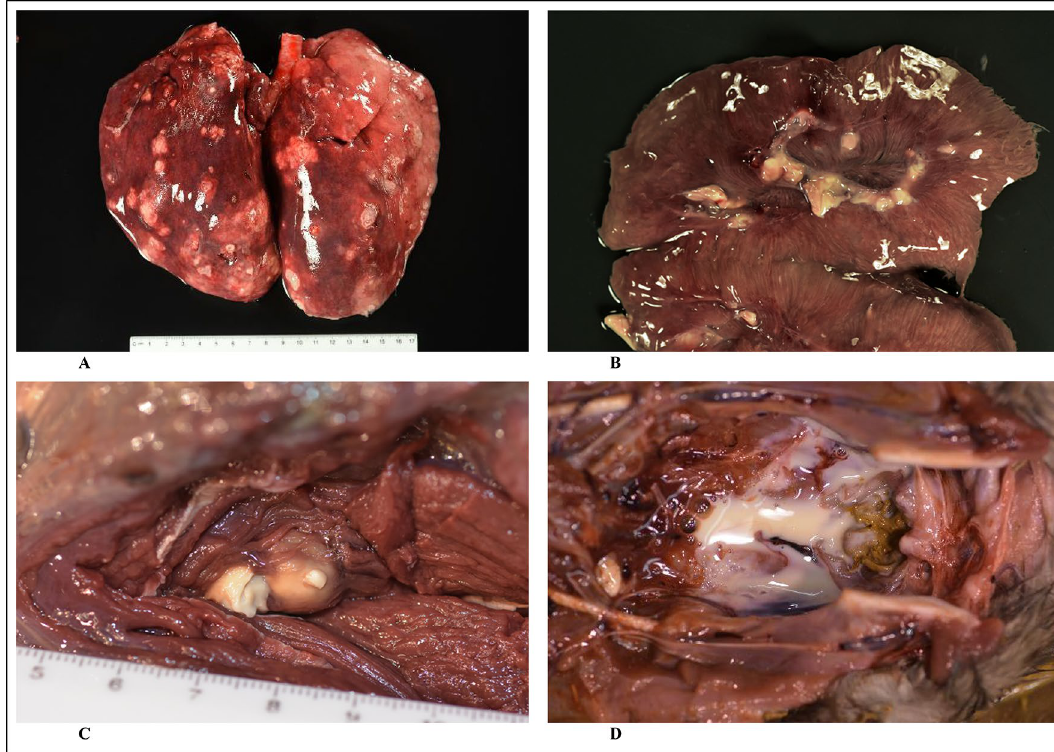
Figure 1. Pathological lesions of Eurasian beavers (C . fiber ) infected with BVL-positive S. aureus . ( A ) Severe suppurative necrotizing pneumonia (animal B); ( B ) severe suppurative pyelonephritis (animal G); ( C ) caseous lymphadenitis, popliteal lymph node (animal E); ( D ) urinary bladder with pyuria (animal